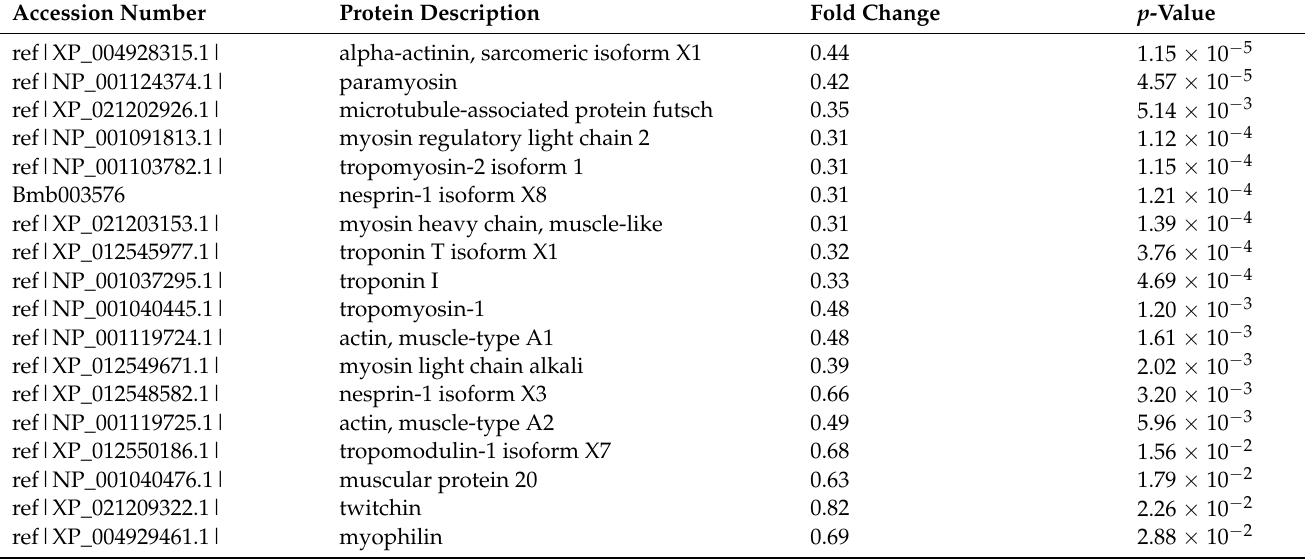
Table 2. The cytoskeletal protein expression pattern in PL after thermal